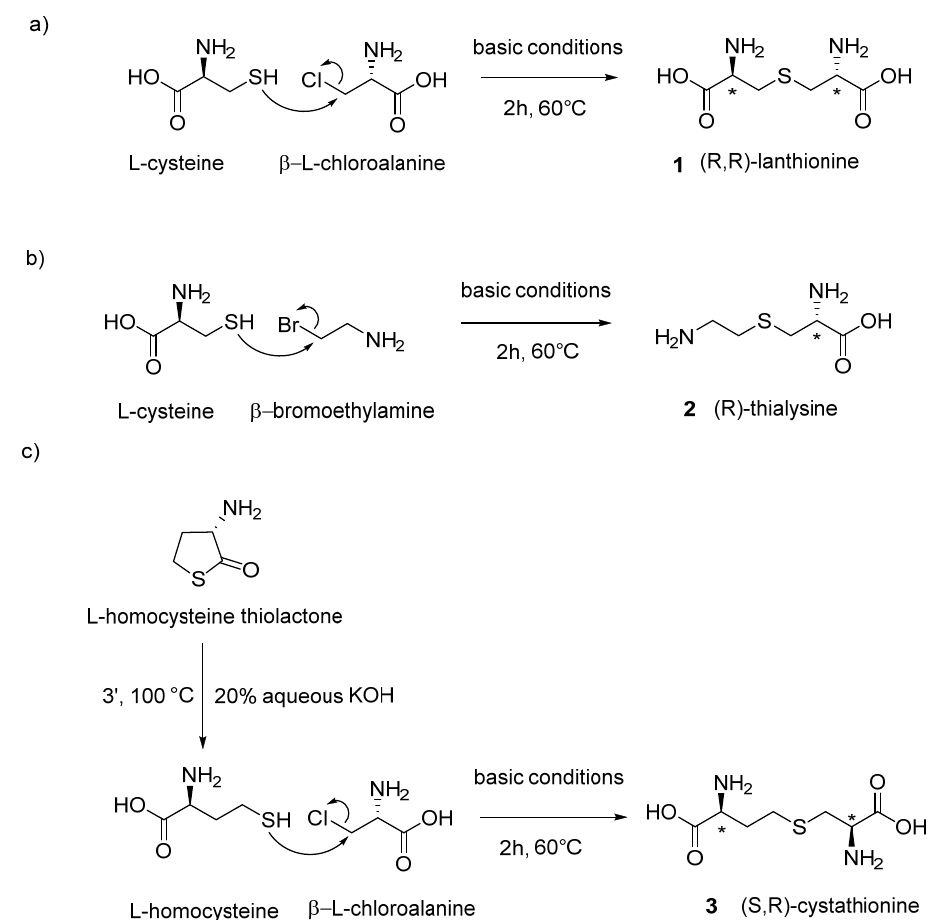
Figure 3. Schematic synthetic routes for the chemical production of the biological linear lanthionines (belonging to the L-series isomers, * denotes the chiral centers). ( a ) Lanthionine (1), ( b ) thialysine (2), ( c ) cystathionine (3).